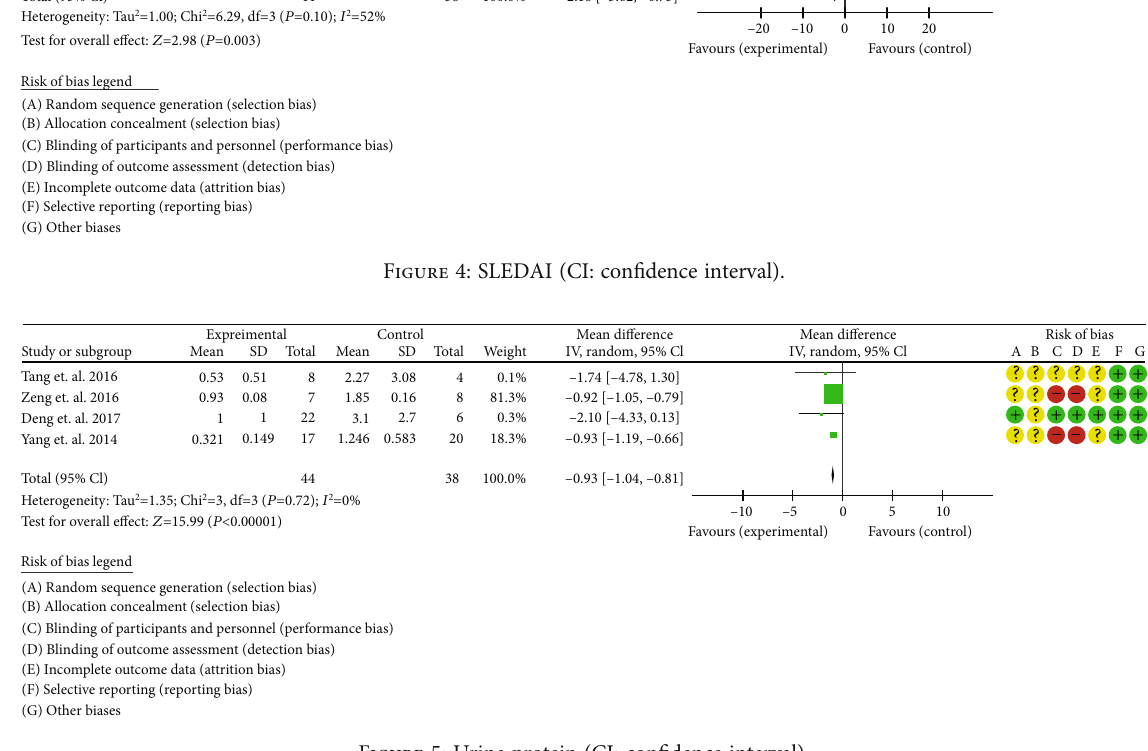
Figure 5: Urine protein (CI: con fi dence interval).